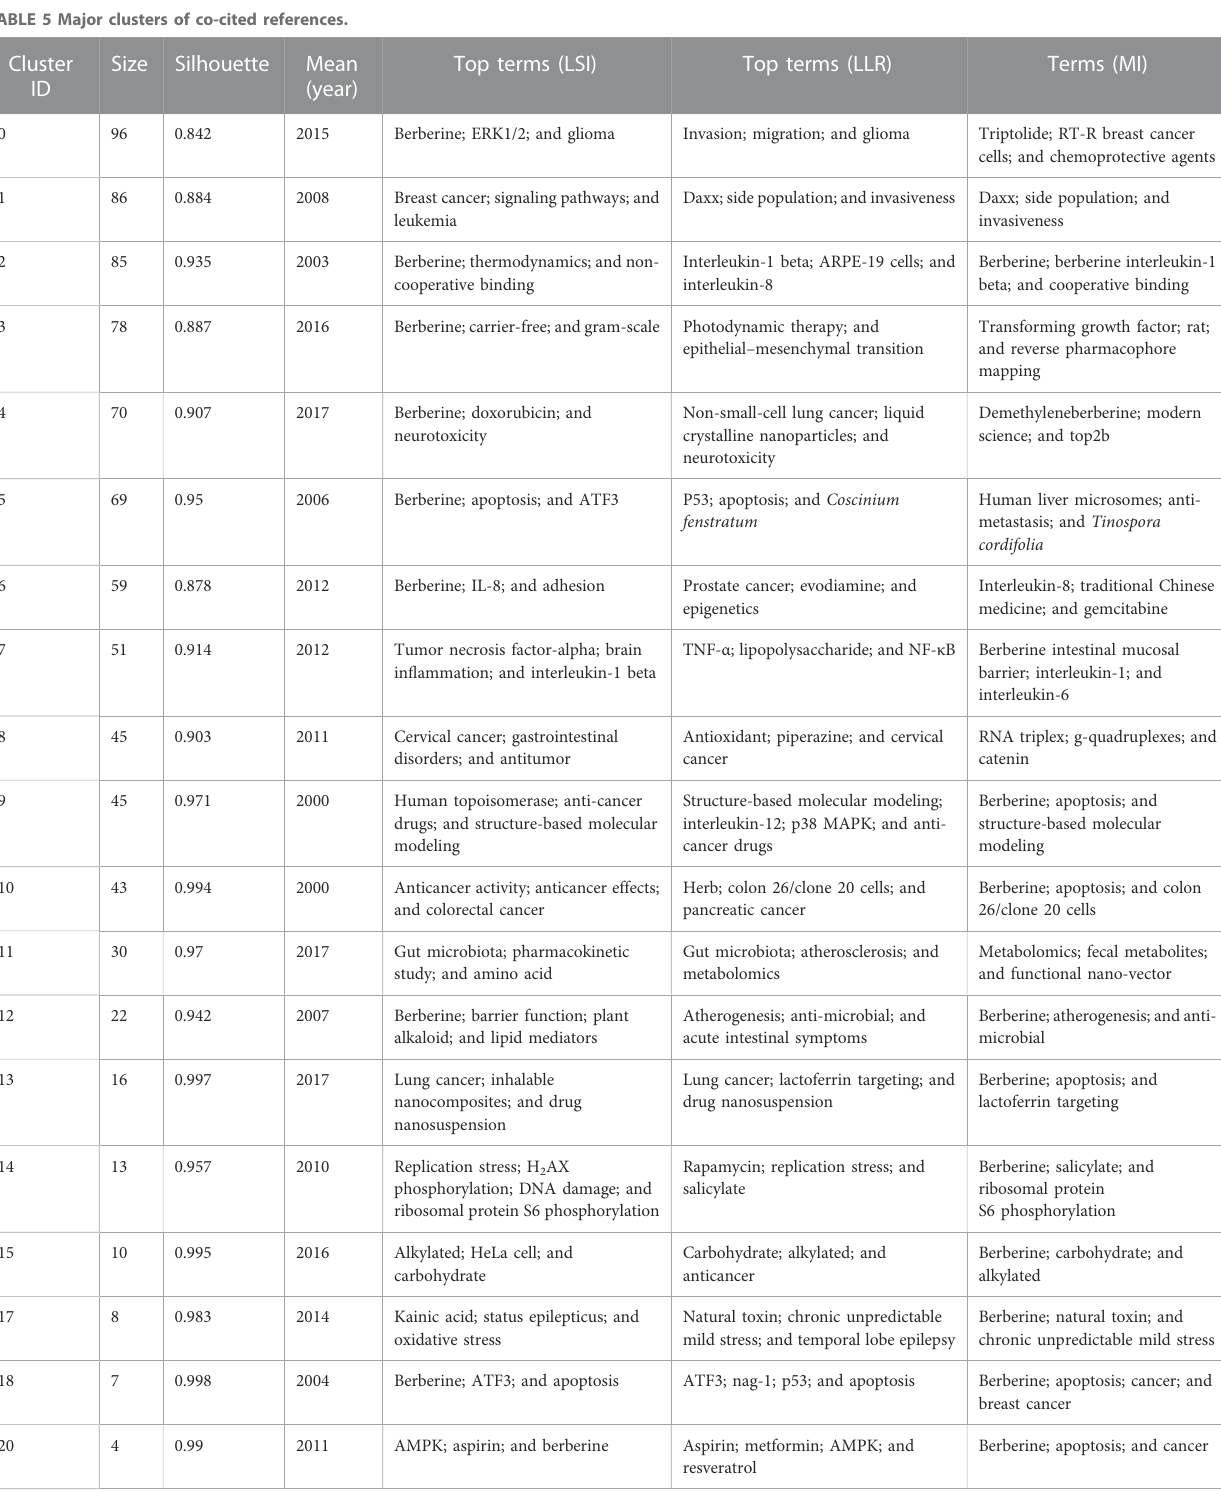
TABLE 5 Major clusters of co-cited